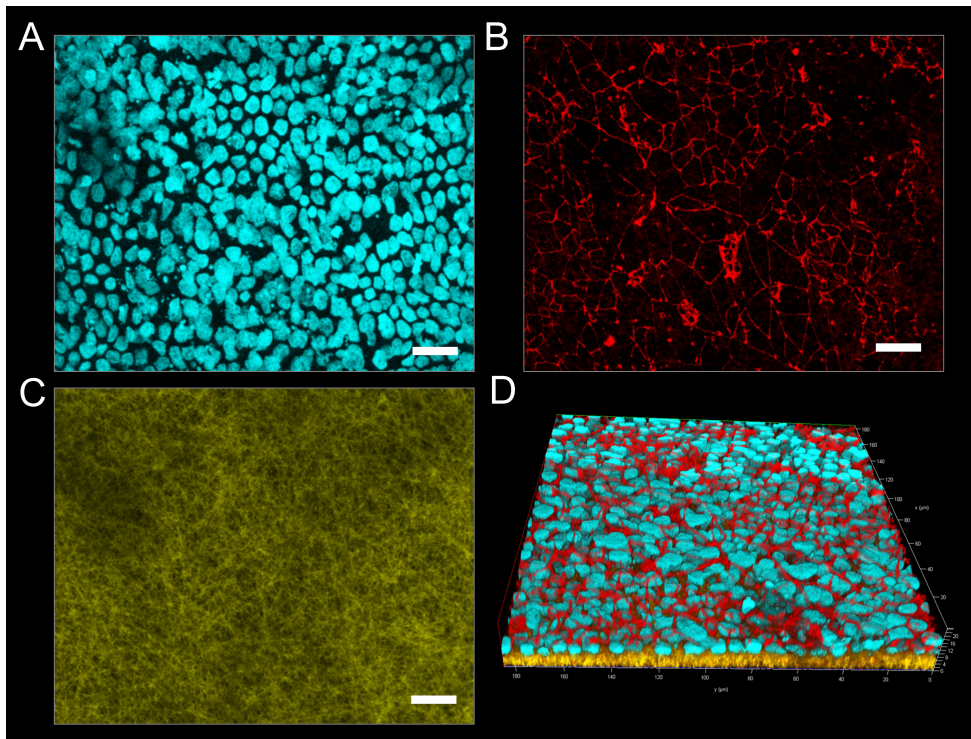
Figure 8. ( A – C ) Representative confocal immunofluorescence images of hiPS-BCECs on gelatin fibers. hiPS-BCECs were stained for cell nuclei (cyan) ( A ), displaying occluding (red) ( B ) on electrospun fibers. ( D ) Z-stack images of hiPS-BCECs on electrospun gelatin scaffolds. Scale bars represent 20 µm.